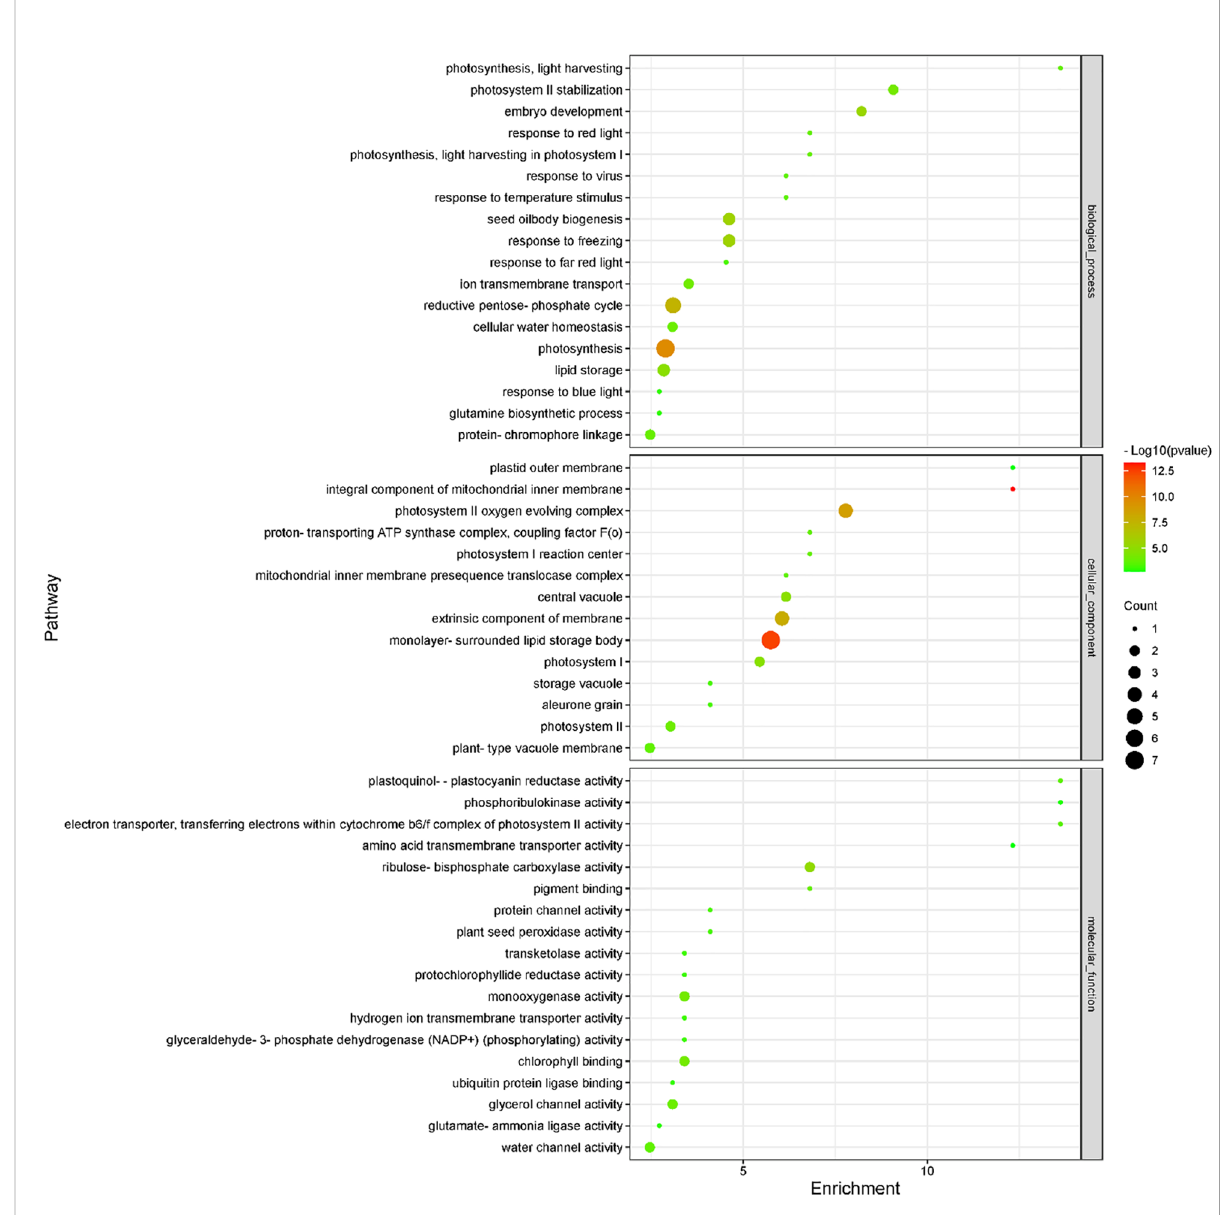
FIGURE 6 Enriched GO terms of light-regulated pathways at radicle protrusion stage. The size of the circle represented the number of genes enriched in the pathway, and the color of the cluster represents the con fi dence interval, and p -value was calculated from hypergeometric